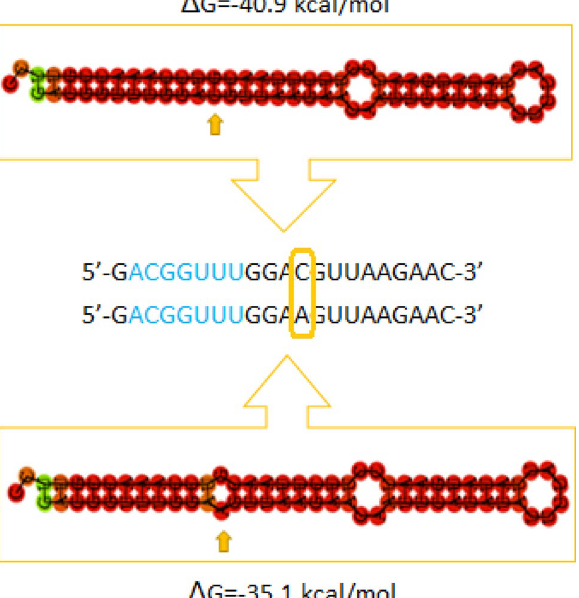
Figure 5. Graphical visualization of an SNP (C>A; rs334271387) identified in the sequence of ssc-miR-7141-5p and its impact on the hairpin secondary structure and its minimal free energy (MFE; ΔG). The seed region is highlighted in blue, while the SNP is framed. The yellow arrow shows the SNP localization and a bulge which it created.